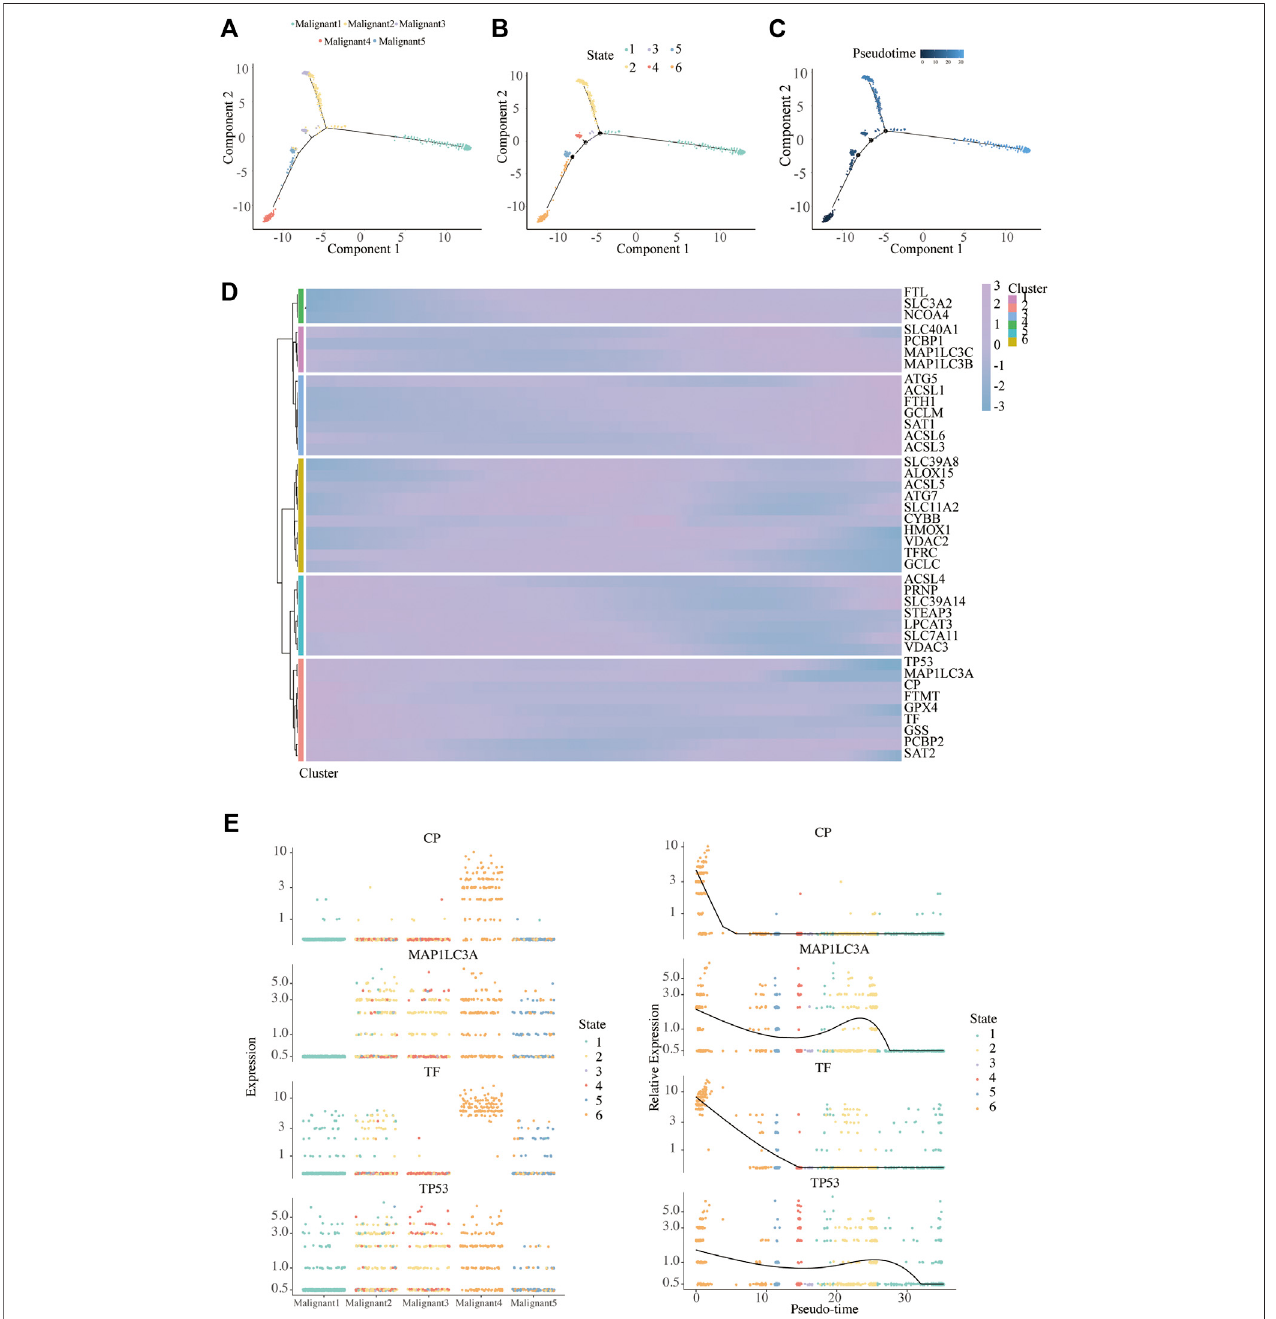
FIGURE 6 | Pseudo-Time analysis. (A – C) Distribution of malignant cells on the pseudo-time trajectory. Cells are colored based on malignant subpopulation (A) , state (B) andpseudo-time (C) . (D) Heatmap showstheexpression offerroptosis-relatedgenesalongthepseudo-timeineachcellcluster. (E) Clusteringandexpression kinetics of four genes along the pseudo-time. Dot plot shows the variability of gene expressions in each malignant subpopulation (left) and following pseudotime (right) based on cell states.